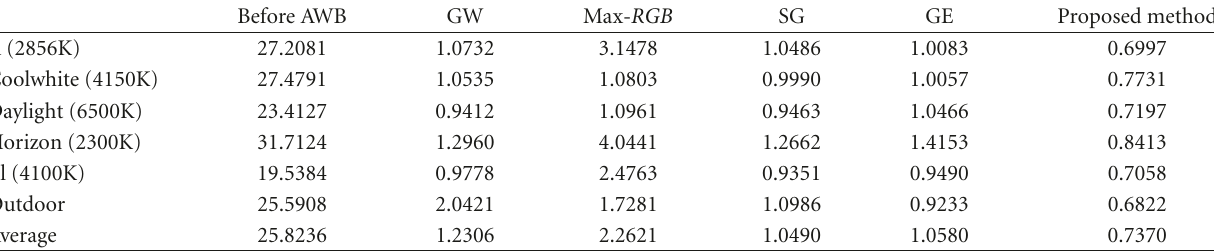
√ Table 3: The average Cb 2 + Cr 2 of a checker board image under six di ff erent color temperature light sources. Before AWB